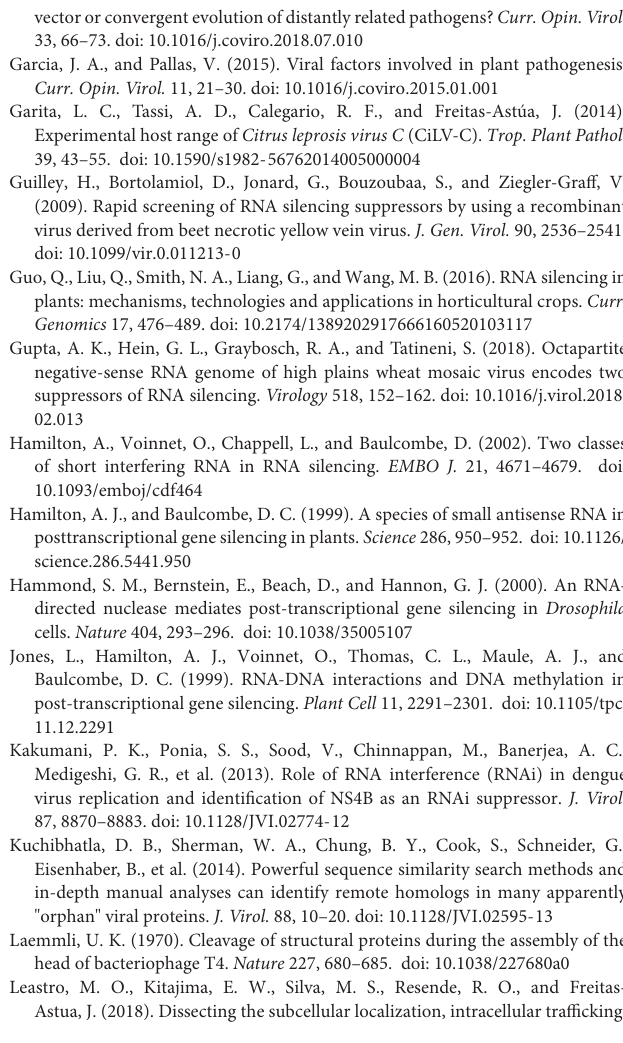
5’terminal region (p61fs). The schematic representation shows the